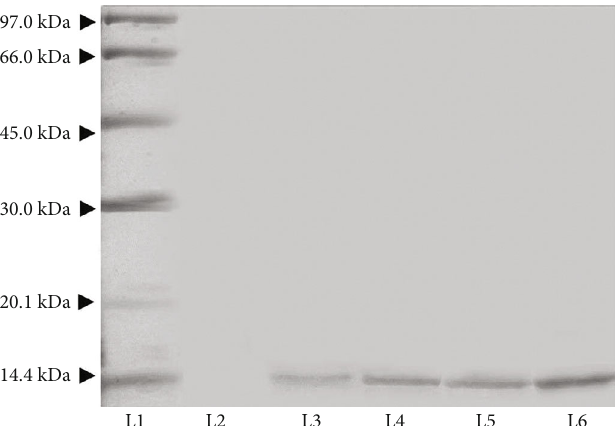
Figure 5: Western blot analysis using monoclonal anti-polyhistidine-peroxidase antibody as a direct antibody. Lane 1: low molecular weight protein ladder, and lanes 2-6 are Lactococcus lactis cell lysate from the bacterial growth from day 1 to 5.